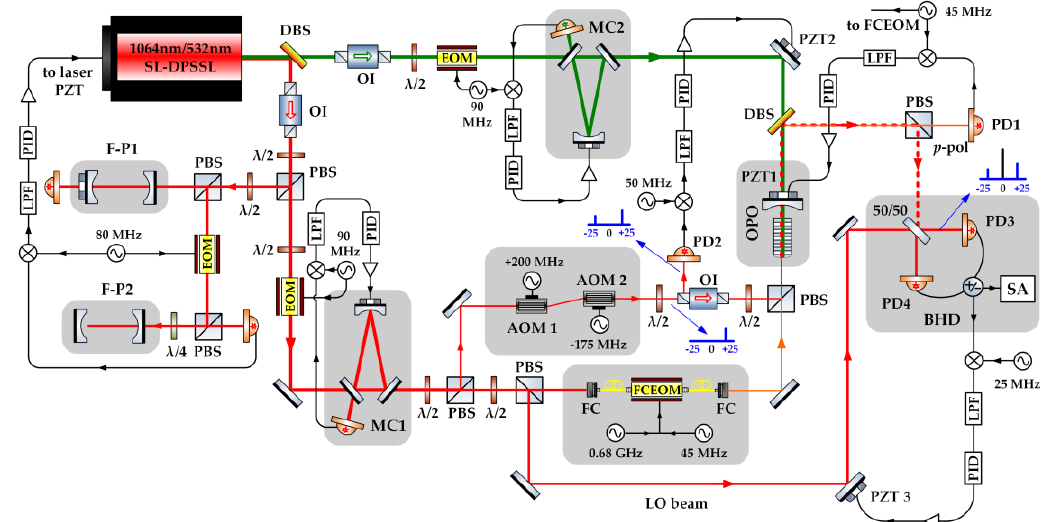
Figure 2. Schematic of the experimental setup used to generate squeezed vacuum states. OI, Optical isolator; F-P, Fabry–Perot cavity; MC, mode cleaner; FC, fiber coupler; EOM, electro-optical modulator; FCEOM, fiber coupled EOM; AOM, acousto-optic modulator; OPO, optical parametric oscillator; DBS, dichroic beam splitter; PBS, polarizing beam splitter; λ/2, half wave plate; λ/4, quarter wave plate; PZT, piezo-electric transducer; PD, photodetector; SA, spectrum analyzer; PID, proportional-integral-derivative; LPF, low pass filter; ⨞ , high voltage amplifier; ⨂ , mixer; +/−, positive/negative power combiner; , signal generator.